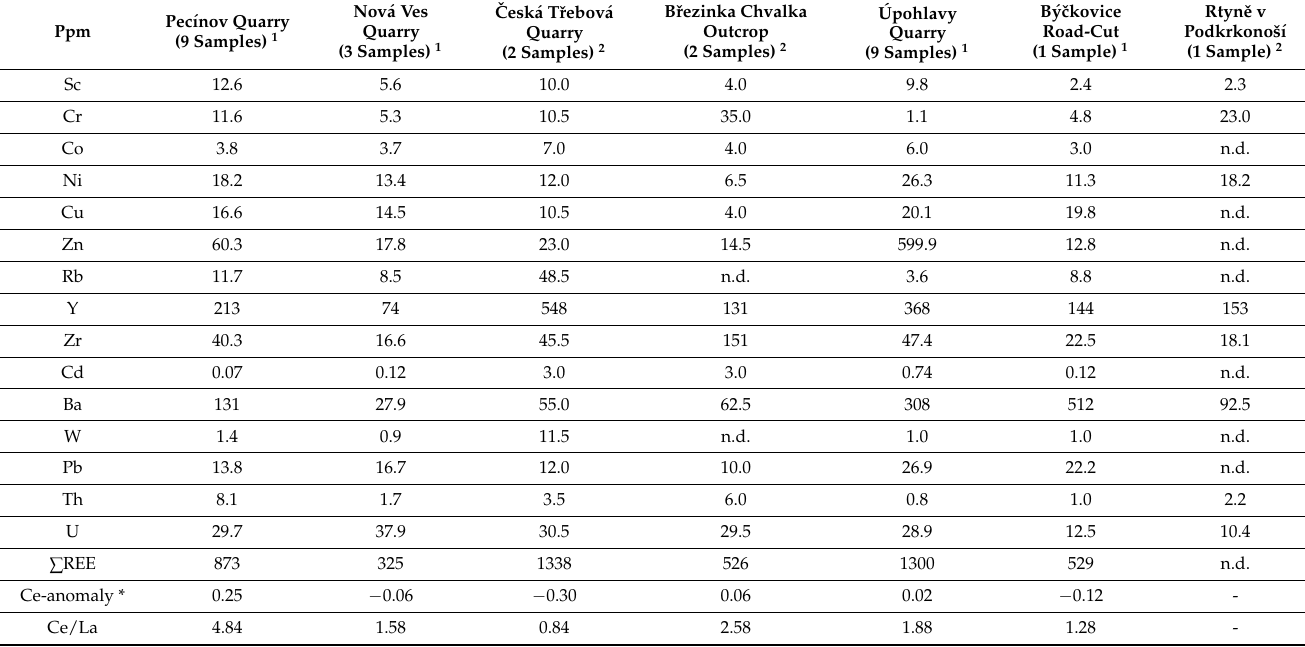
Table 4. Average trace element concentrations of the Turonian